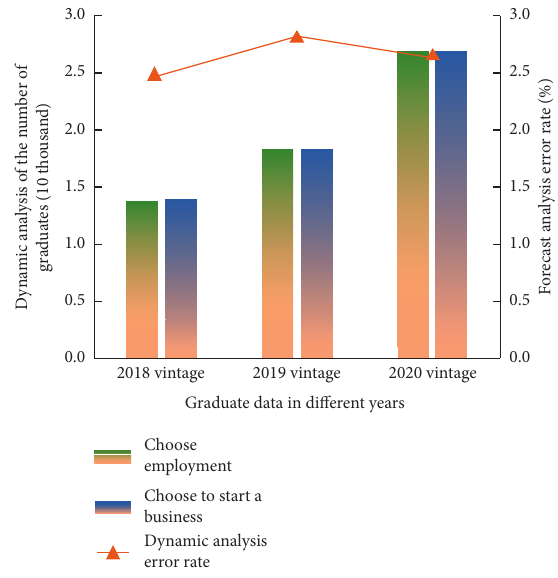
Figure 8: Dynamic analysis results of employment and